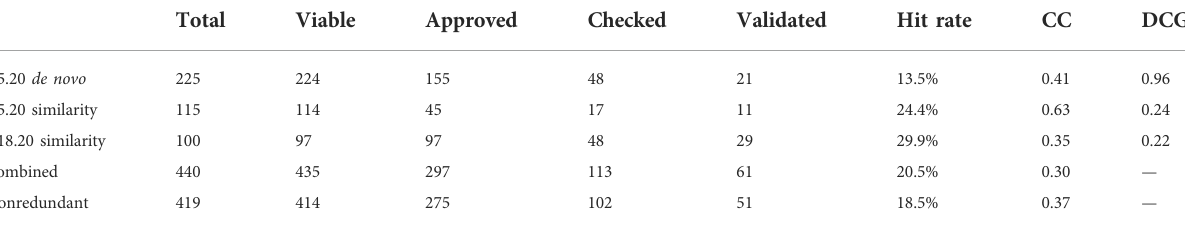
TABLE 1 Summary details of drug candidates generated by the CANDO platform. For each candidate list, the total number of candidates that were initially generated by ourprediction modules, the numberof viable candidates aftermanual fi ltering (removing ions anddyes) prior tovalidation, the number of approved compounds, the number of candidates that were matched via literature search using the CoronaCentral and GHDDI resources ( “ Checked ” ), the number of candidates with EHR evidence or in vitro activity less than 100 μ M ( “ Validated ” ), the hit rate percentage, the Pearson correlation coef fi cient ( “ CC ” ) between the full virus validation ranks and their EC50 scores (including the combined and nonredundant lists), and the discounted cumulative gain ( “ DCG ” ) score are given. Overall, we obtained hit rates ranging from 13.5 to 29.9% using the CANDO platform, with the signature similarity pipelines yielding the highest success rates and the direct viral inhibition de novo pipeline accurately ranking the best, most potent,